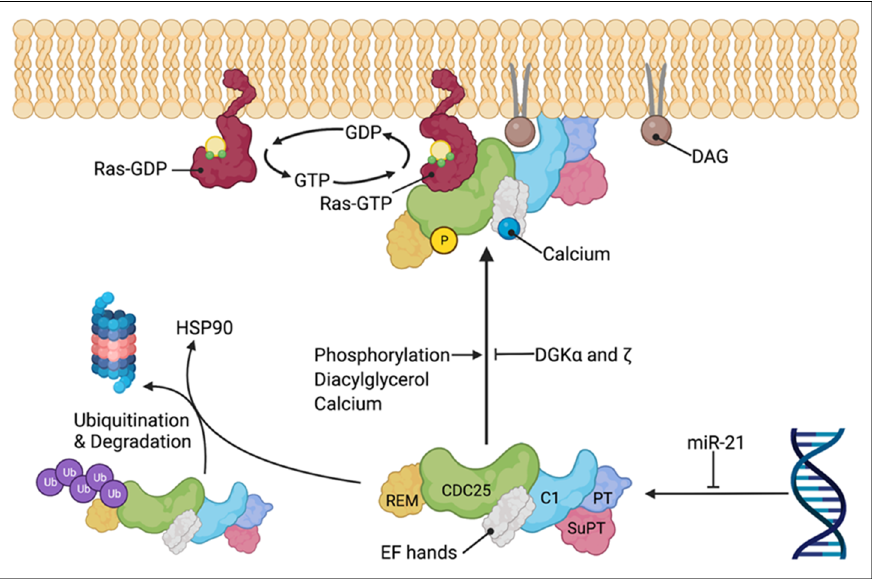
Figure 3. Model of RasGRP1 regulation and plasma membrane translocation. RasGRP1 is sequestered in the cytoplasm in its inactive state (lower center) and translocated to the plasma membrane or endomembrane upon activation (upper center). RasGRP1 activation involves phosphorylation of threonine 184, DAG binding by C1 domain, and calcium binding by the EF hands. Termination of RasGRP1 signaling is mediated by the breakdown of DAG to PA by DGK α and DGK ξ . RasGRP1 can be suppressed by miR-21 and degraded following disassociation from HSP90 and polyubiquitination. Active RasGRP1 catalyzes the release of GDP from Ras and facilitates their transition from inactive GDP-bound to active GTP-bound state. Created with BioRender.com.